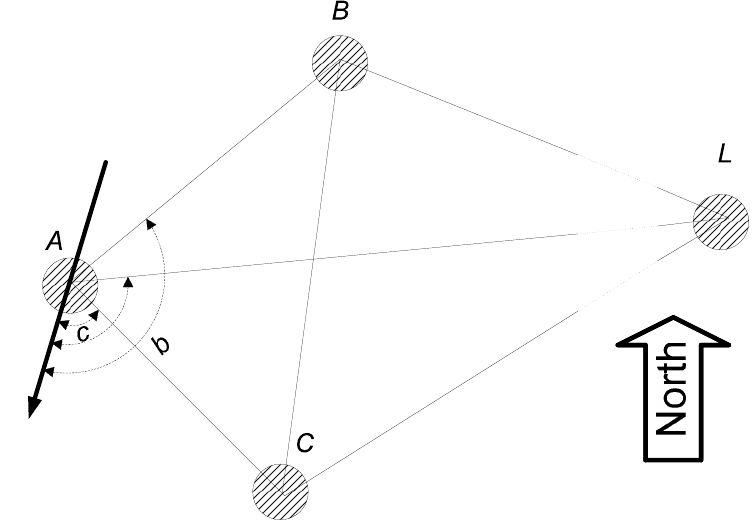
Figure 2. Node A computes its bearing to L using information from B and